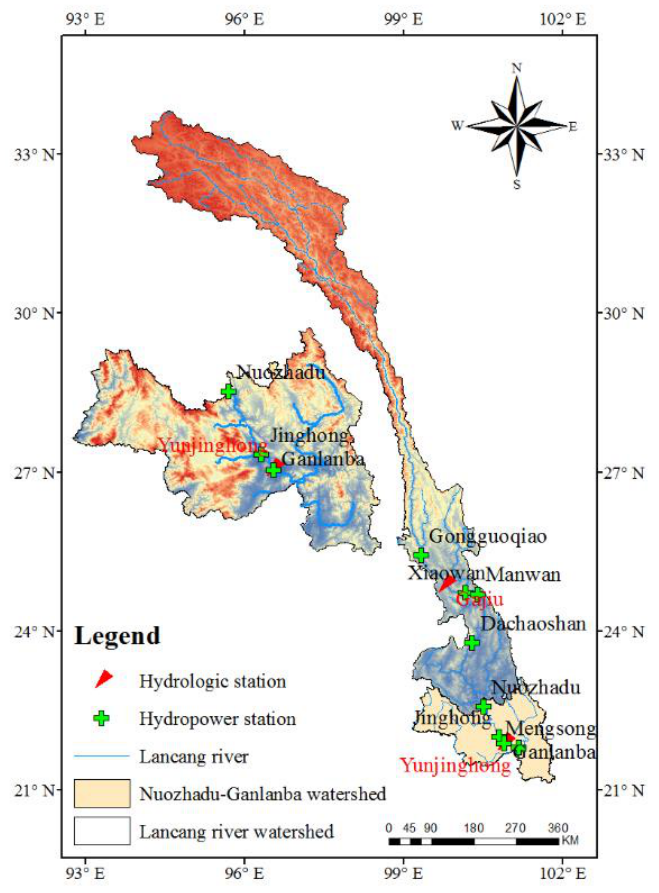
Figure 1. The location of the Lancang River.